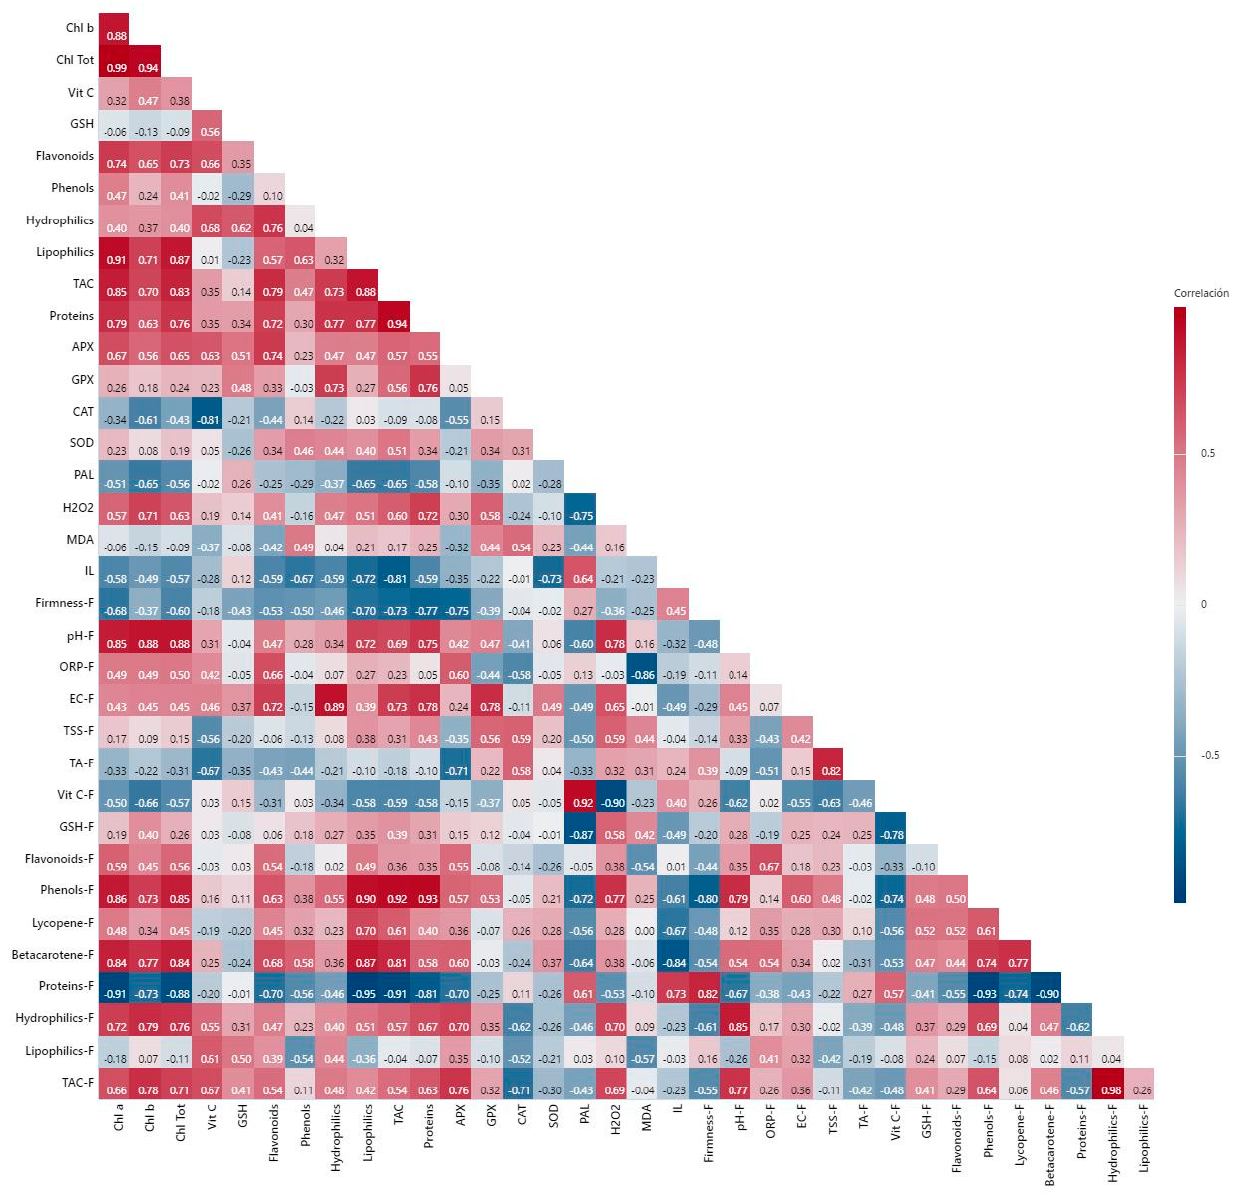
Figure 8. Pearson’s correlation of all variables obtained from non-stressed plants. Chl a: chlorophyll a; Chl b: chlorophyll b; Chl Tot: total chlorophylls; Vit C: vitamin C; GSH: glutathione; Hydrophilics: hydrophilic antioxidant capacity; Lipophilics: lipophilic antioxidant capacity; TAC: total antioxidant capacity; APX: ascorbate peroxidase; GPX: glutathione peroxidase; CAT: catalase; SOD: superoxide dismutase; PAL: phenylalanine ammonia lyase; MDA: malondialdehyde; IL: ion leakage; ORP: oxidation reduction potential; EC: electrical conductivity; TSS: total soluble solids; TA: titratable acidity. The “F” in front of each word represents each variable determined in fruits.